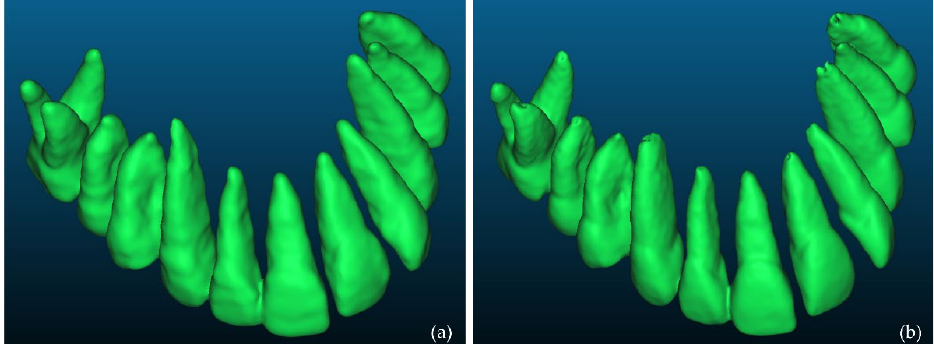
Figure 16. 3D models of teeth after their processing using Geomagic Wrap; ( a ): Experiment 2 (manual segmentation); ( b ): Experiment 4 (semi-automatic segmentation).